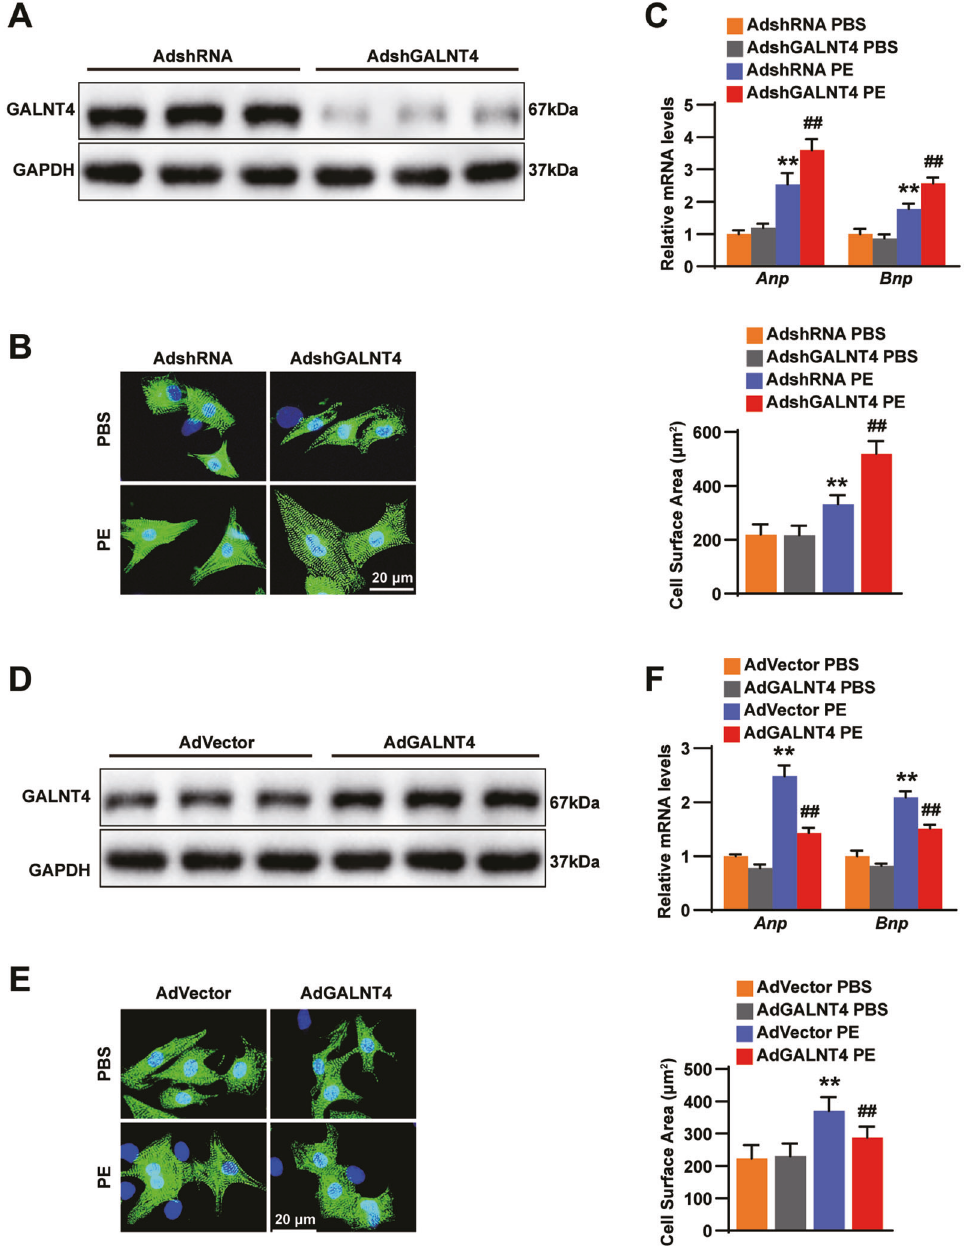
Fig. 2 GALNT4 suppresses PE-induced cardiomyocytes hypertrophy. A The overexpression of GALNT4 was veri fi ed by western blotting of cardiomyocytes ( n = 3 independent experiments). B Immuno fl uorescence staining images of NRCMS treated with AdshGALNT4 or AdshRNA after treatment with PE or PBS in each group ( n = 30-40 cells). C Changes in cardiac hypertrophy markers were assessed after treatment with PE or PBS by real-time PCR ( n = 3 independent experiments). D GALNT4 protein levels after transduction with AdGALNT4 and control ( n = 3 independent experiments). E Immuno fl uorescence staining images of cells infected with AdGALNT4 or AdVector and treated with PE or PBS ( n = 30-40 cells). F The level of cardiac hypertrophy markers in NCRMs was detected by real-time PCR ( n = 3 independent experiments). ** p < 0.01 vs. AdshRNA PBS or AdVector PBS, ## p < 0.01 vs. AdshRNA PE or AdVector